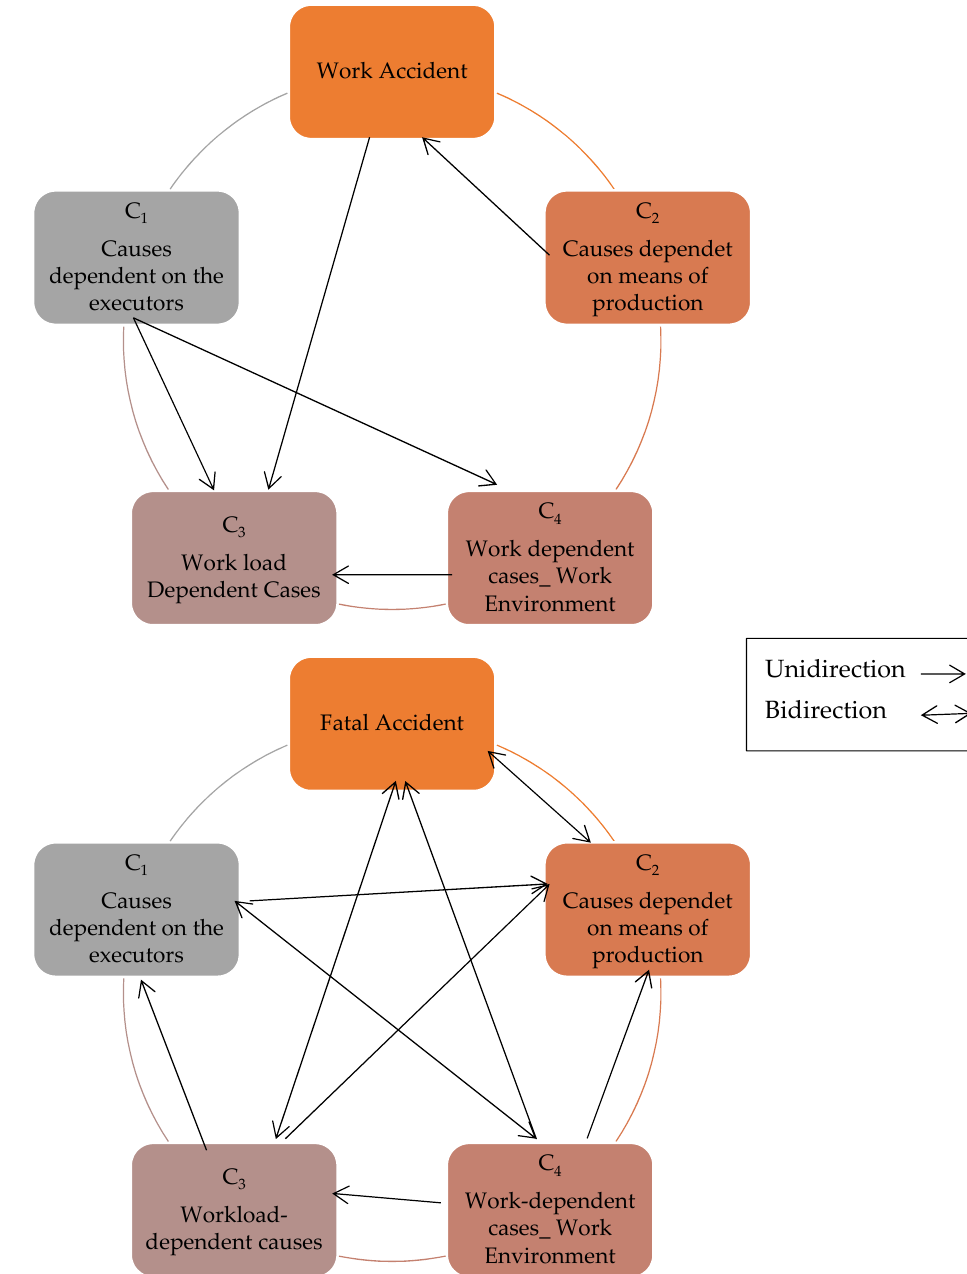
Figure 3. Summary of Granger causality tests for short run.